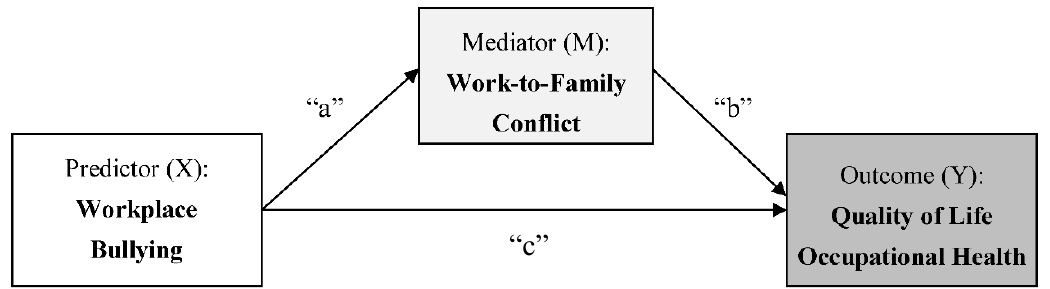
Figure 1. Conceptual model examining the effect of workplace bullying on employees’ well-being outcomes mediated by work-to-family conflict. Note : “a × b” indicates the indirect effect of X on Y through M. “c” indicates the total effect of X on Y.